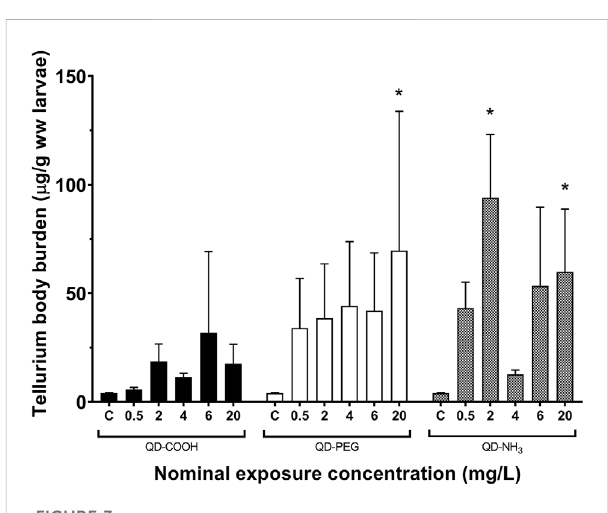
FIGURE 3 TotalTeconcentrations(mean±standarderrorexpressedasµg/ g ww larvae) in Danio rerio larvae after exposure to increasing concentrations of QD-COOH, QD-PEG and QD-NH 3 . Single asterisk (*) indicates signi fi cance from control ( p < 0.05, T